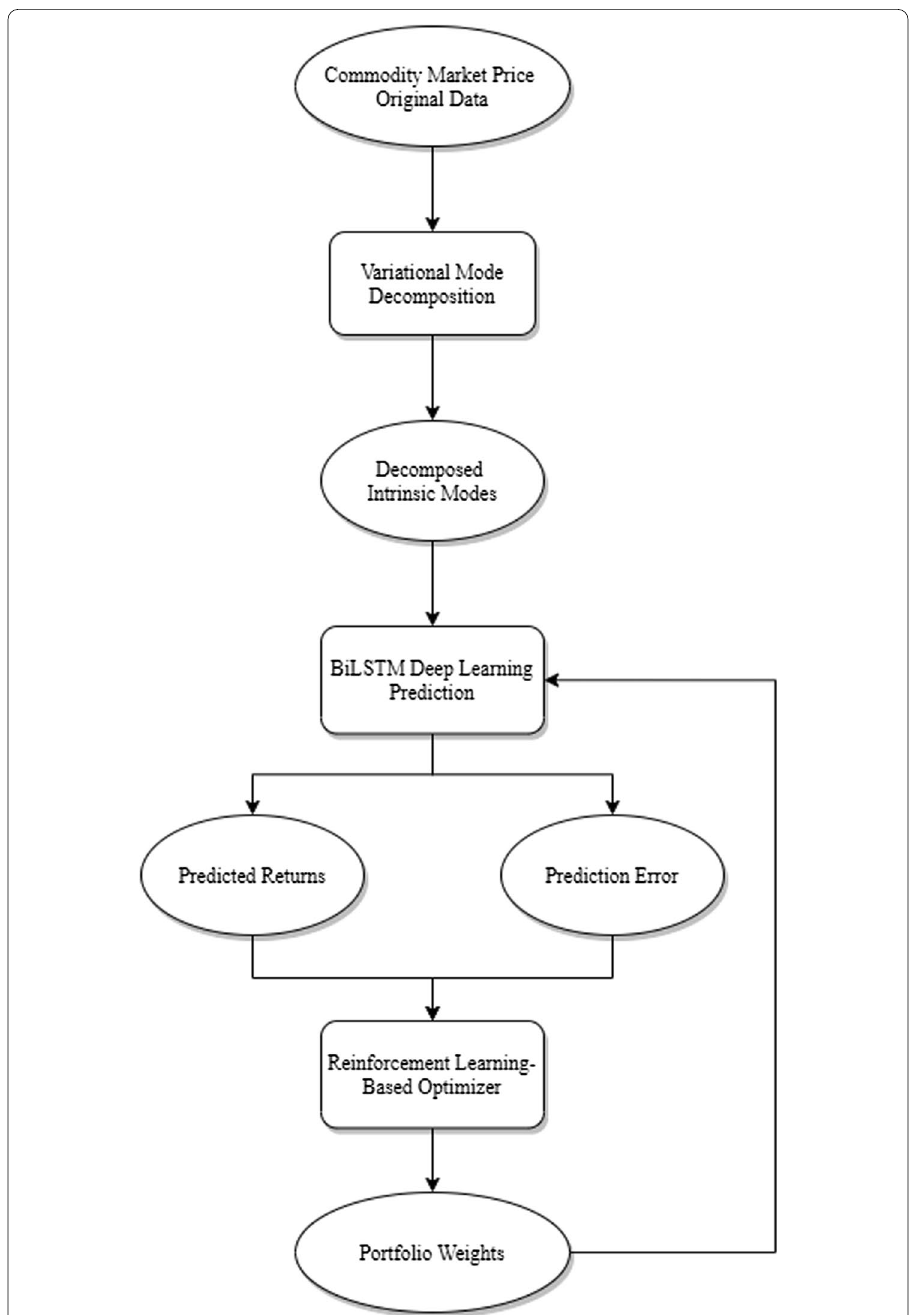
Fig. 1 Portfolio optimization and NEPO